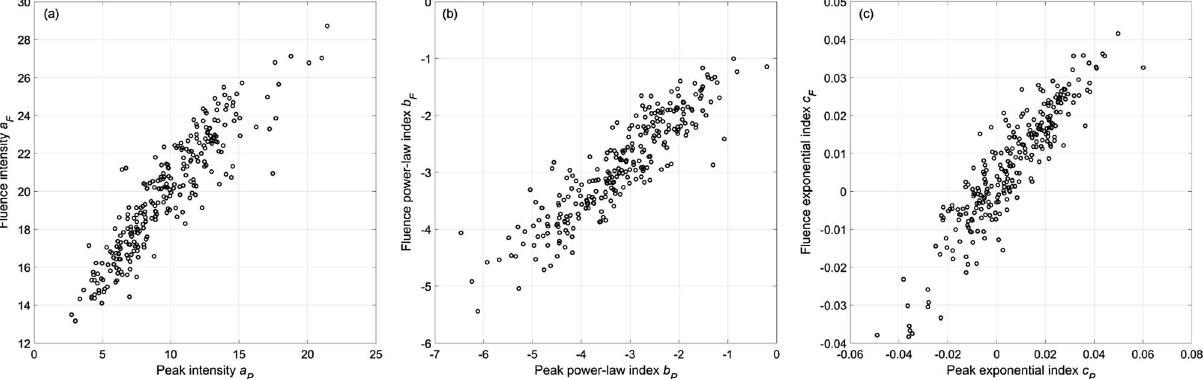
Fig. 4. Cross-plots of the spectral parameters of Fluences and Peaks showing the relationships between them. (a) Spectrum intensity a , (b) power-law index b and (c) exponential index c .